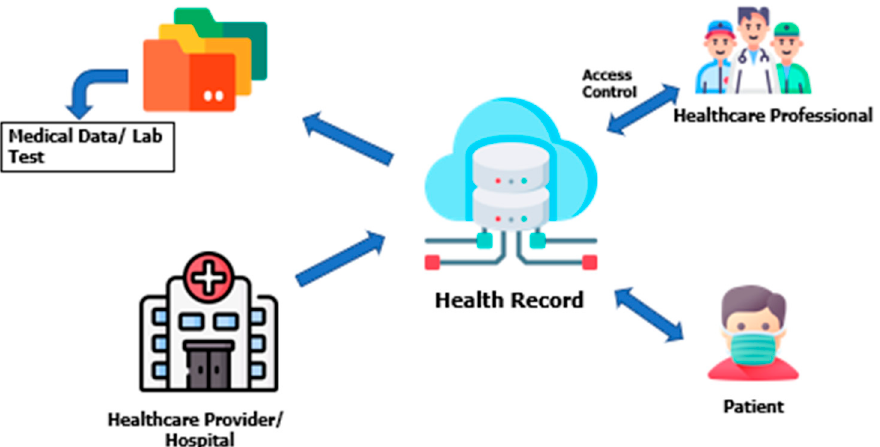
Figure 1. Overview of the current system.